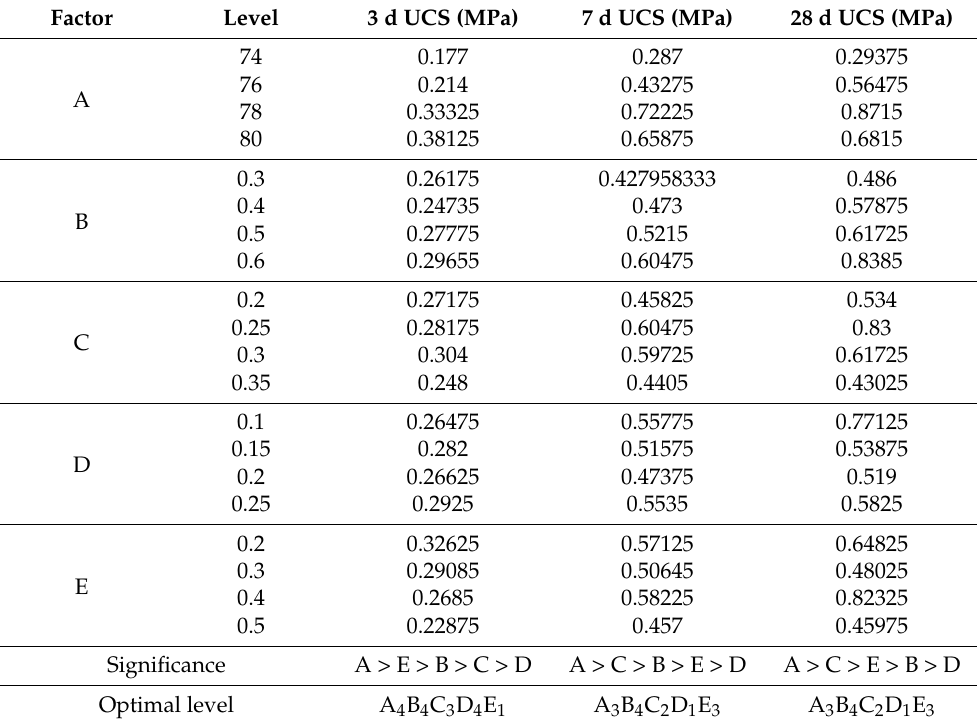
Table 4. Range analysis of compressive strength of coal based solid waste backfill at different curing